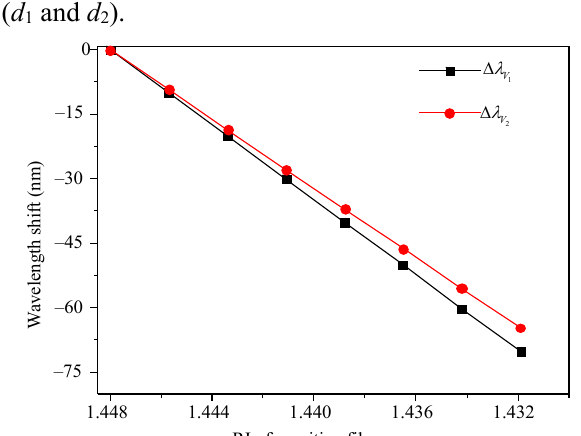
Fig. 3 Effect of sensitive film RI on the sensitivity.